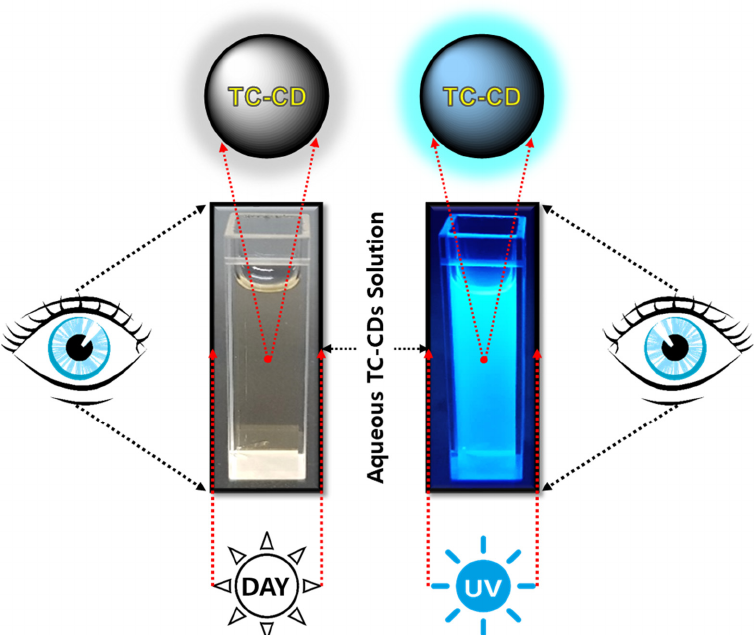
Figure 6. Photographic images of aqueous TC-CDs solutions exposed under daylight (left) and 365 nm UV light (right) as viewed by the naked eye. Furthermore, their photostability is well known, and this photostability of the syn- thesized TC-CDs is intrinsic to their real-time (practical) applications. Hence, the TC-CDs aqueous solution was continuously exposed to UV light illumination for 120 min, and the stability (fluorescence intensity) of the TC-CDs was investigated. The fluorescence inten- sity of the TC-CDs remained almost the same, even after continuous UV light irradiation for 120 min (Figure S3). The digital photographs of the TC-CDs aqueous solution under 365 nm UV light before and after UV light irradiation provide further support for the pho- tostability of the synthesized TC-CDs. In the photographic image (inset Figure S3), insig- nificant changes can be observed by the naked eye under continuous exposure to UV light excitation for 120 min. These results confirm that the TC-CDs have anti-photobleaching (excellent photostability) properties, making them promising fluorescence candidates for practical applications [44,63]. 2.3. Bioimaging Applications of Synthesized TC-CDs The synthesized TC-CDs were used directly as a staining agent (fluorescent nano- probe) for cellular imaging due to their ideal properties, such as tunable fluorescence emission, reasonable quantum yield, excellent water dispersibility, durable anti-photo- bleaching, low cytotoxicity, and good biocompatibility. A cell viability test was conducted before performing cellular imaging because the cell viability assay was essential for cellu- lar imaging [64]. Hence, the cytotoxicity of the TC-CDs against human colon carcinoma cells (HCT-116) was examined using the 3-(4,5-dimethylthiazol-2-yl)-2,5-diphenyl te- trazolium bromide (MTT) assay. The resulting bar graph of the cytotoxicity of TC-CDs at different concentrations (0–200 μ g mL − 1 ) against HCT-116 cells is presented in Figure S4. These results demonstrated that the synthesized TC-CDs exhibited insignificant cytotoxi- city towards HCT-116 cells, even at a high concentration of 200 μ g mL − 1 . The cell viability